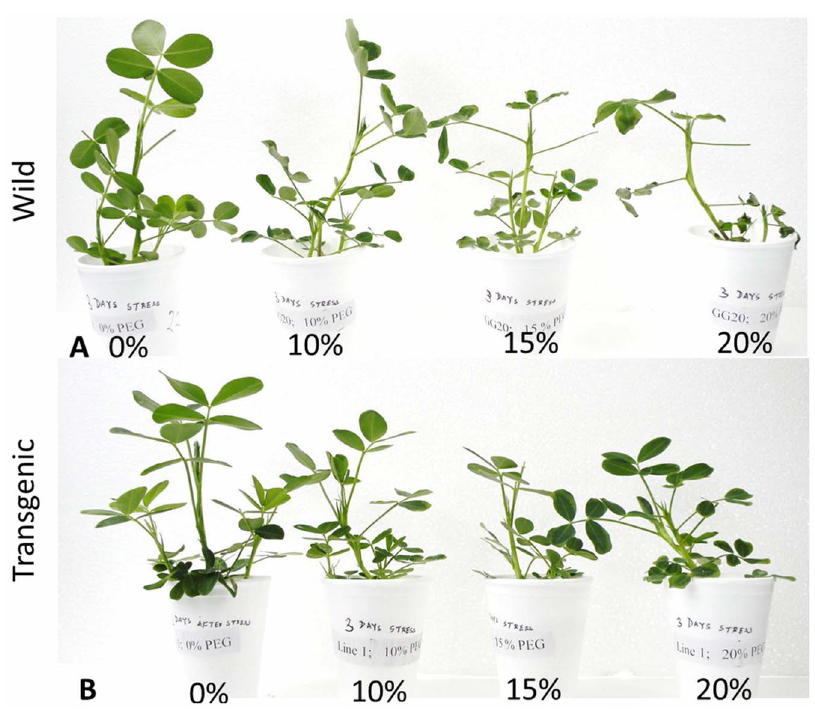
Fig. 4. Seedlings of wild type (A) and transgenic line (B) exposed to 0, 10, 15, 20% PEG for 3